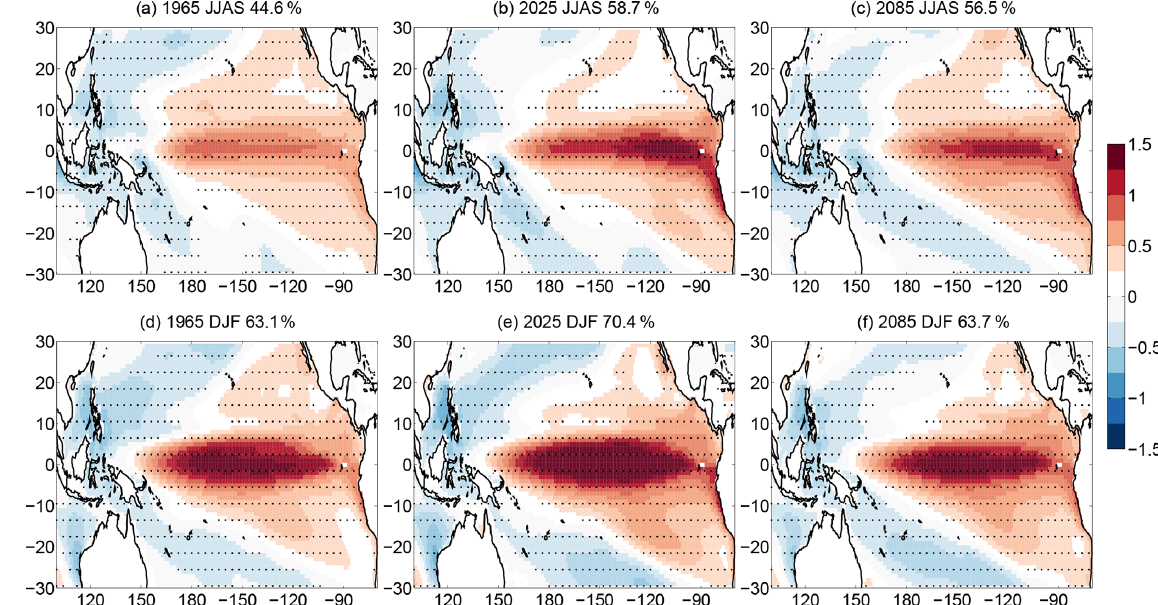
Figure 1. Ensemble-based SST regression maps [in degrees Celsius] for years given in the title of the panel for (a–c) JJAS and (d–f) DJF. The explained variance in the first SEOF mode is also displayed in the title of the panels. Dots represent geographical locations where the regression coefficient is significant at the 95% level. For better visibility, only every fourth grid point is